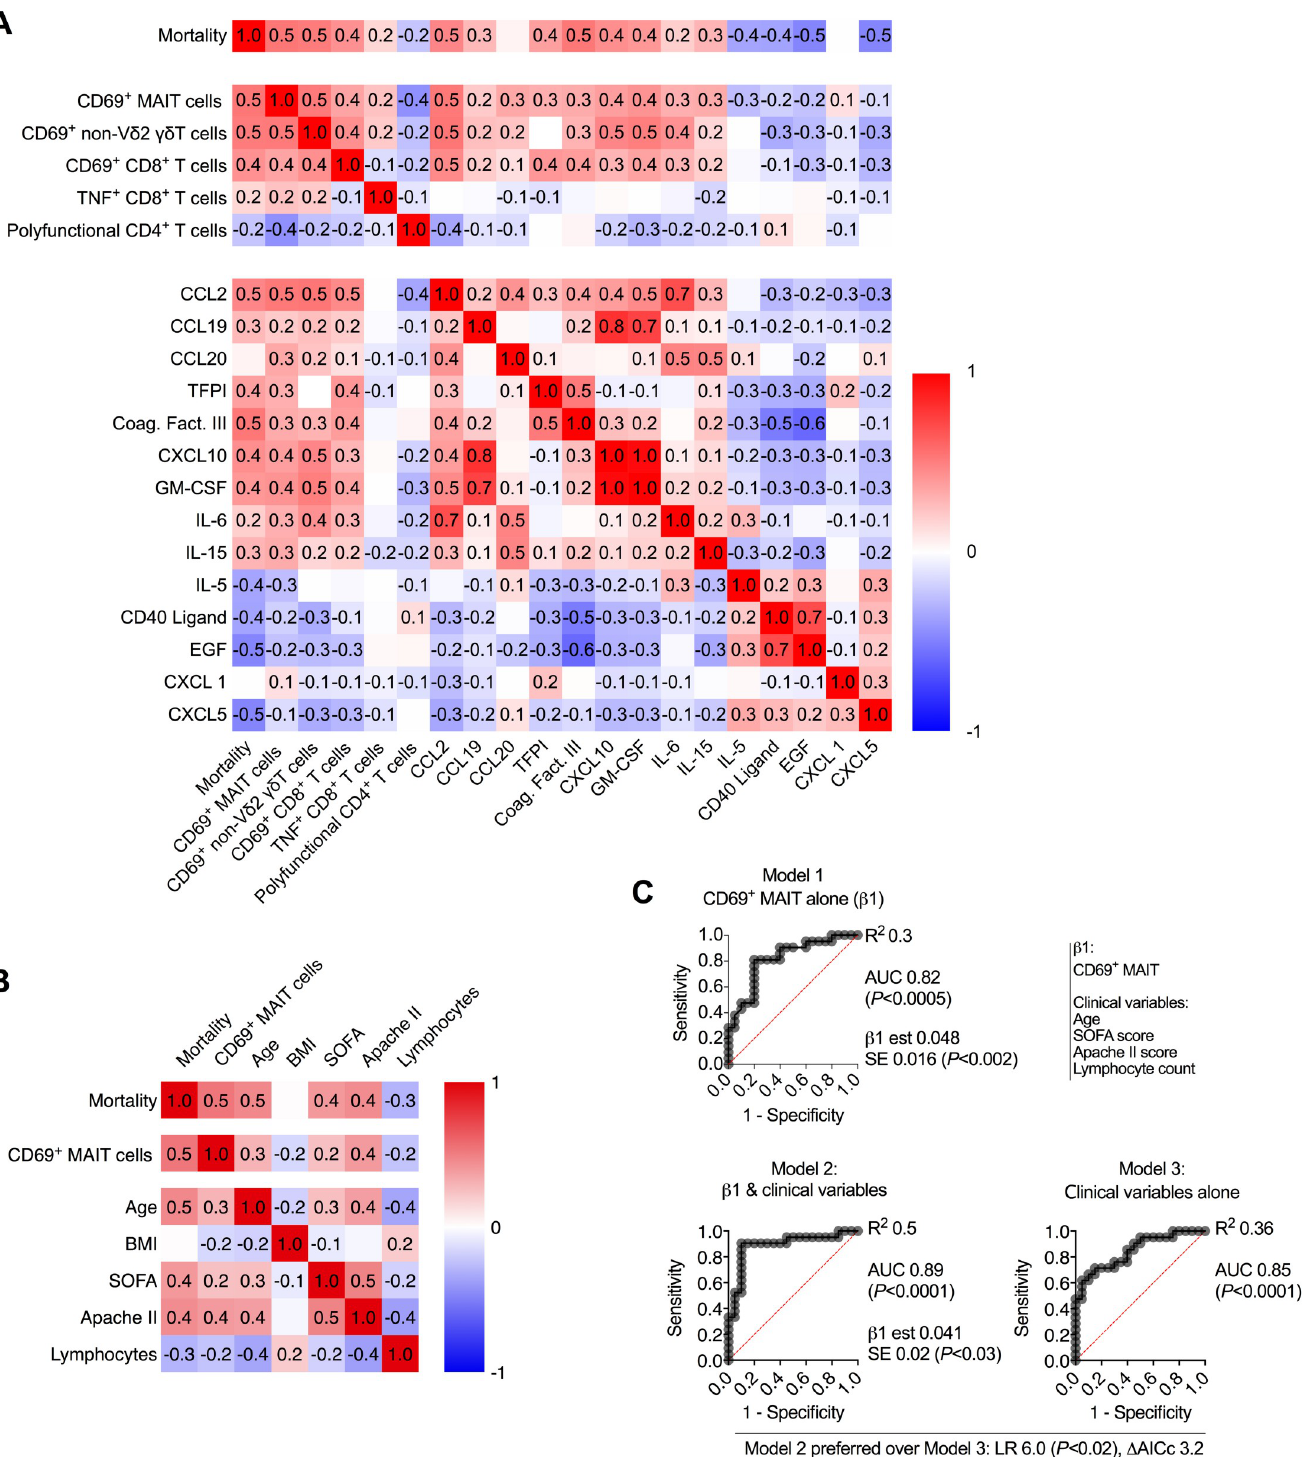
Fig 4. Activation of MAIT cells is associated with worse disease outcomes in critically ill COVID-19. (A) Pearson correlation of mortality with all statistically significant immunologic parameters. (B) Pearson correlation of mortality, MAIT cell CD69 expression, clinical measures, and timing of sampling. (C) ROC curve of MAIT cell CD69 expression (Model 1), ROC curve of MAIT cell CD69 expression combined with clinical variables (Model 2), and ROC curve of clinical variables alone (model 3). LR: likelihood ratio, Δ AICc: Difference in Akaike’s Information Criterion corrected.